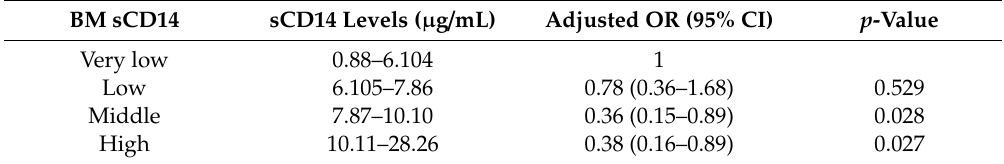
Table 3. Logistic regression analysis for the e ff ects of 1-month BM sCD14 on AD at 9 months of age. BM sCD14